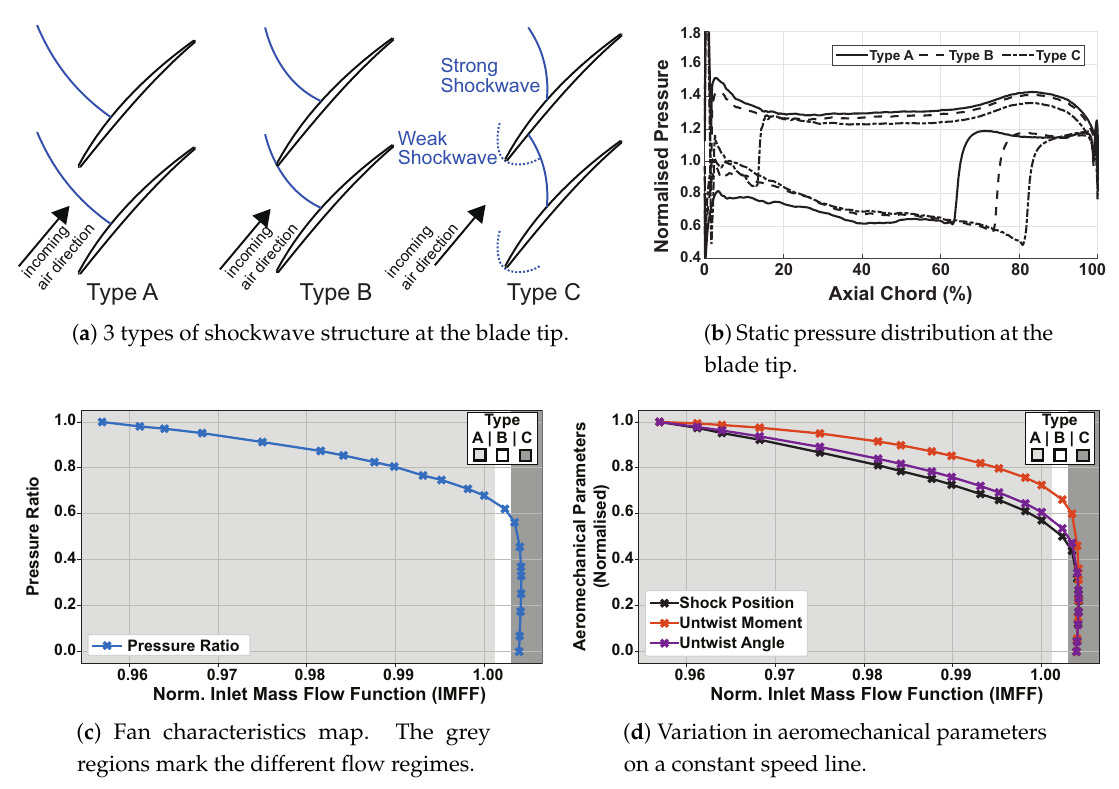
Figure 4. Three types of flow regimes on a constant speed line. Aeromechanical data from fan 1 are presented. The above discussion is on the untwist behaviour of a perfectly symmetrical